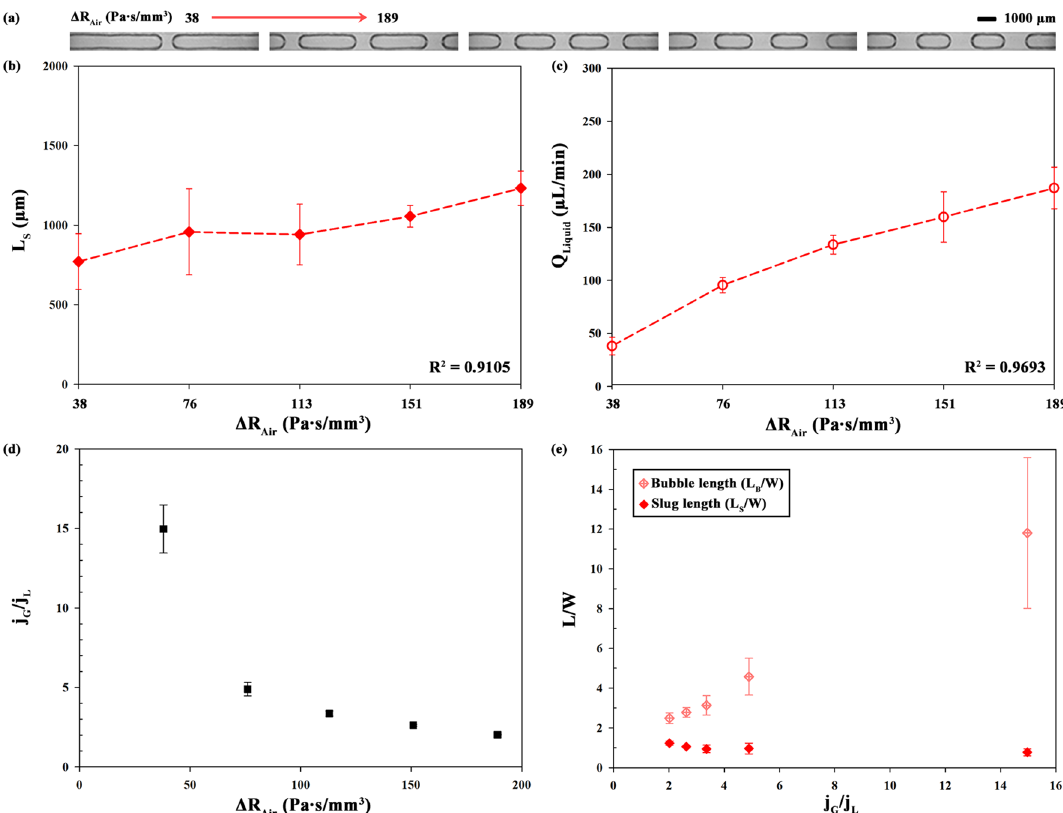
Figure 4. ( a ) Representative images in 3D-printed chip depending on hydraulic resistance gradient of air [Δ R Air (Pa∙s/mm 3 )]. ( b ) Length ( L S ) of slug, ( c ) flow rate ( Q Liquid ) of slug and ( d ) air–liquid superficial velocity ratio ( j G / j L ) depending on Δ R Air . Correlation coefficients for the given length of tube are R 2 = 0.9105( L S ) and R 2 = 0.9693 ( Q Liquid ). ( e ) Dimensionless length ( L S /W, L B /W) versus air–liquid superficial velocity ratio ( j G / j L